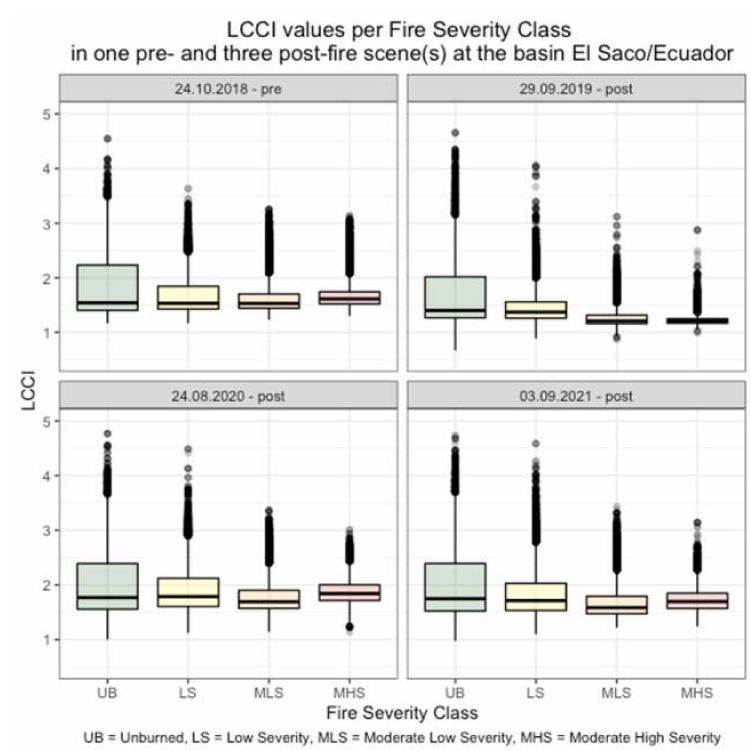
Figure 5. Boxplots of LCCI values in the fire severity classes at the El Saco basin in one pre- and three post-fire Sentinel 2 scenes.